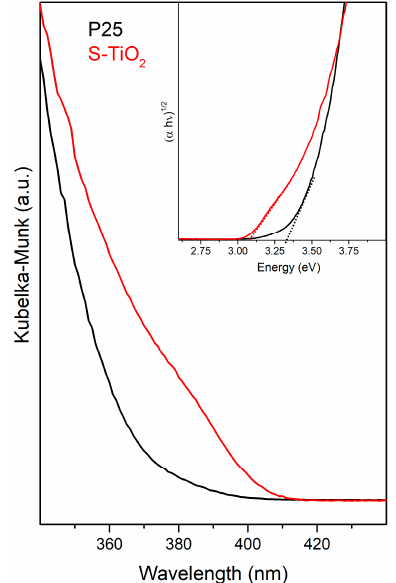
Figure 5. UV-Vis spectra of S-doped TiO 2 (red curve) and pure TiO 2 (black curve) used as a reference material. The Tauc plot of both samples is shown in the inset. An example of a Tauc Plot is reported in ref. [49].